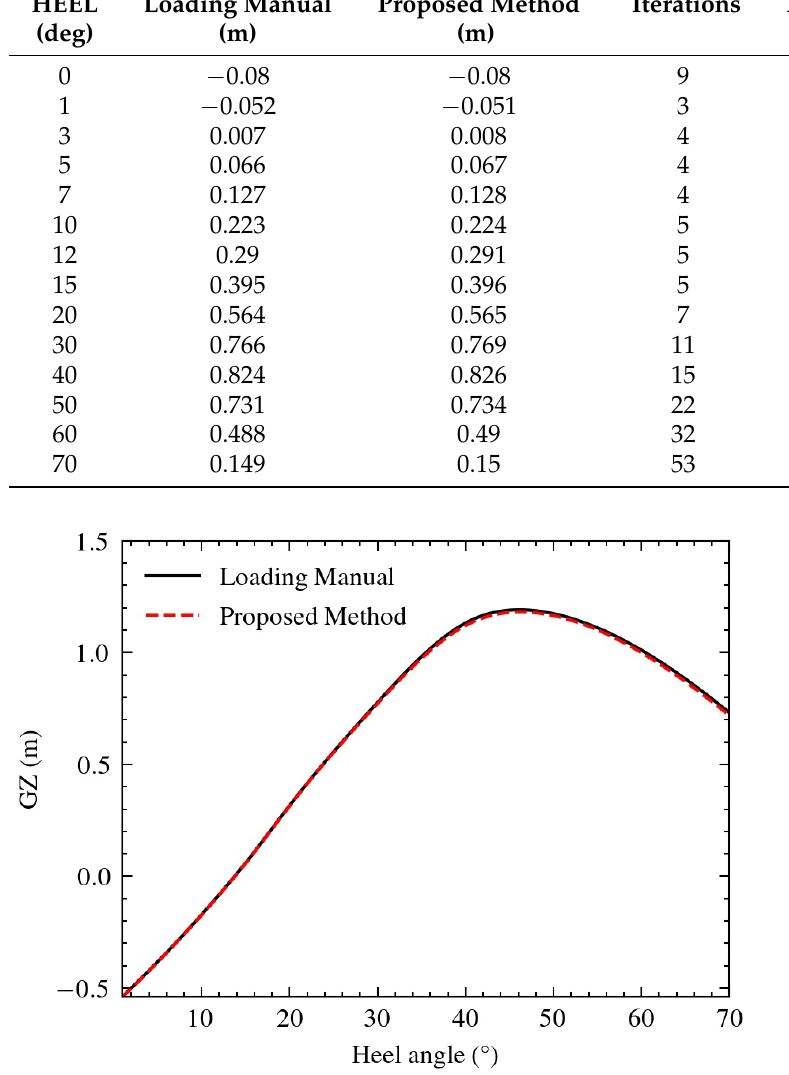
Figure 13. GZ curve of